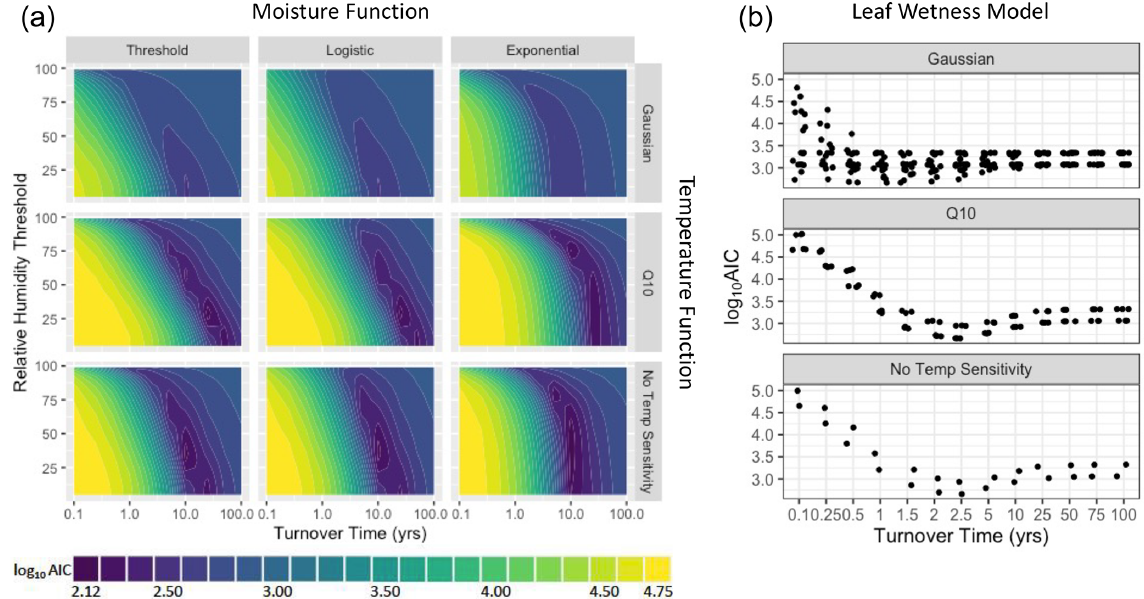
Figure 5. Parameter fits for the first model run showing parameter combinations across a wide range of hypothetical conditions. (a) The three humidity-based NRM functions showing the relationship between turnover time (1 /k int ) and relative humidity threshold ( R T or R 0 . 5 ). Colors represent log 10 AIC scores; models with better fit to the data have lower scores. (b) Parameter estimation for the leaf wetness-based moisture function showing log 10 AIC as a function of turnover time (1 /k int ). Plots have different numbers of points because of different numbers of temperature parameters that were tested (the Gaussian temperature function has two, the Q 10 function has one, and the bottom plot has no temperature parameters, only early-stage and late-stage tiller